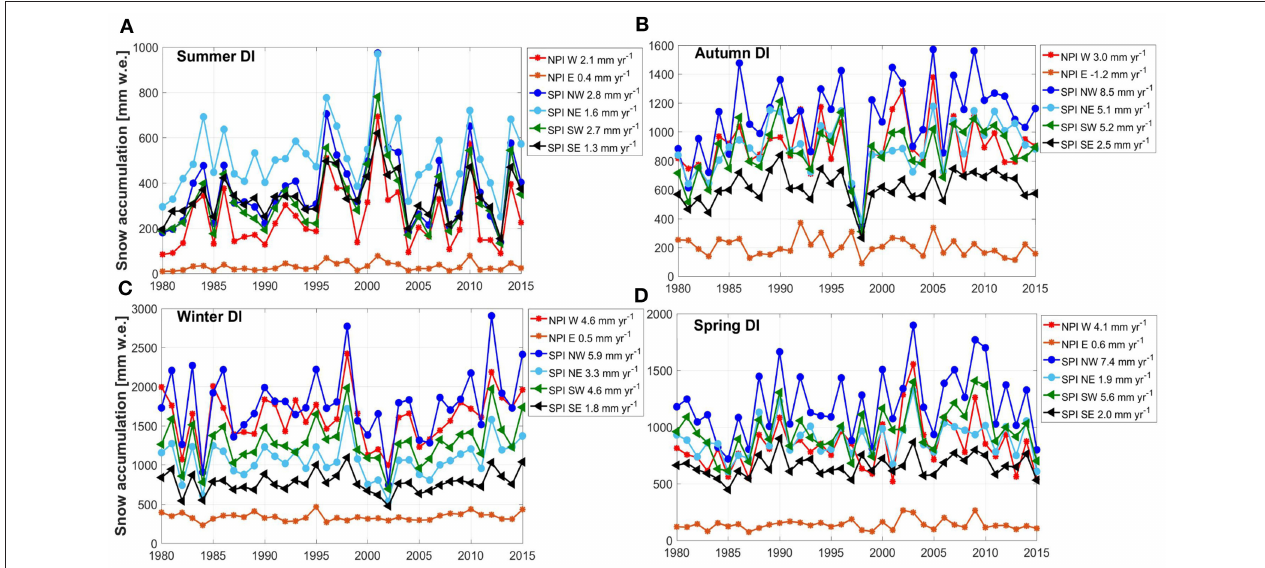
FIGURE 6 | Seasonal time series and trends of the snow accumulation for six sub-regions of the study area using the DI method. (A) Summer, (B) Autumn, (C) Winter and, (D) Spring. The legend also indicates the annual trend. 1,300 mm w.e. while the observations suggest 1,050 mm